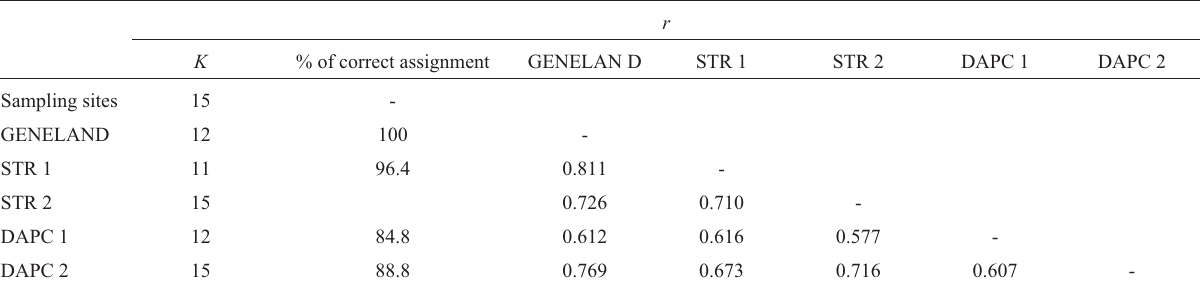
Table 4 - Pairwise comparison of distances between individuals obtained from the probabilities of posterior population membership of individuals, ob- tained by all five grouping methods. K = number of clusters; r = correlation coefficient; p < 0.0005; STR 1= STRUCTURE analysis without prior infor- mation; STR 2 = STRUCTURE analysis with LOCPRIOR option; DAPC 1= DAPC analysis with find.clusters option; DAPC 2 = DAPC analysis with a priori information of